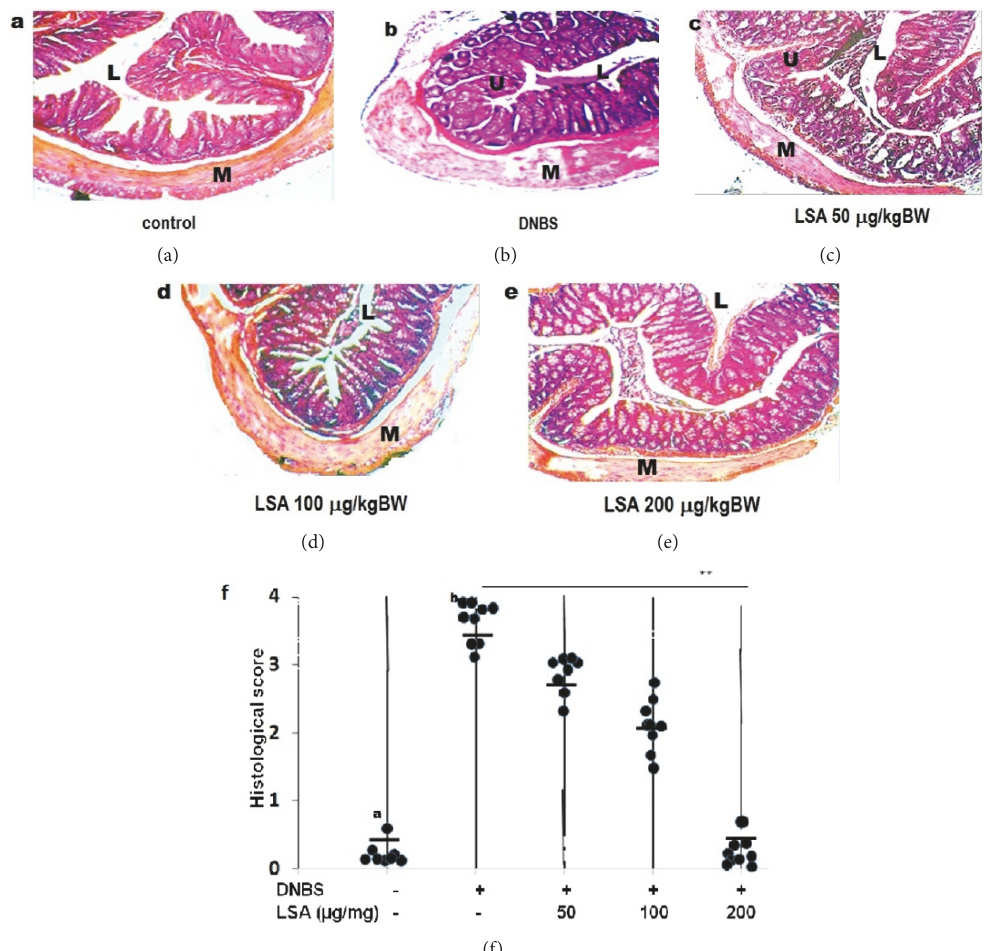
Figure 3: Histological changes with DNBS-induced colitis in mice after 14 days. (a) Mice having instillation of 50% ethanol were used as the control. (b) Mice had rectal instillation of DNBS only. (c–e) Mice had rectal instillation of DNBS and then were injected with different concentration of LSA (50 𝜇 g/mL , 100 𝜇 g/mL, and 200 𝜇 g/mL), respectively. (f) Histological colitis scores of individual mice are shown as circles, and the averages of each group are shown as horizontal bars. Each symbol represents an individual animal. Representative pictures of each group are shown. Groups B and C had significantly higher colitis scores than Group E ((a) p > 0.05 and (b) p < 0.01, respectively). L: gut lumen; M: muscle; U: ulcer; arrow: inflammatory infiltrate. Magnification 200 ×